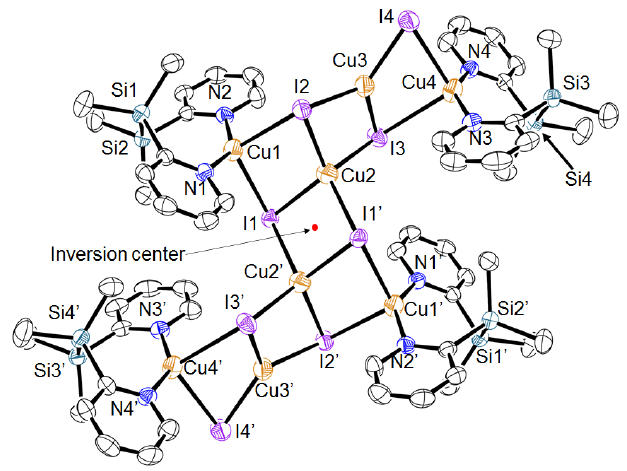
Figure 2. ORTEP drawing of complex 3 with thermal ellipsoids at the 50% probability level. Hydrogen atoms were omitted for clarity. Selected bond distances and angles. Cu1…Cu2, 3.0943(7) Å;